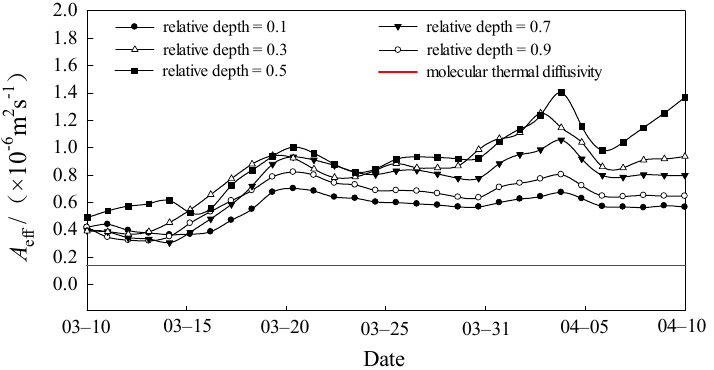
Figure 10. Calculated values of effective thermal diffusivity changed with depth and date of late winter.